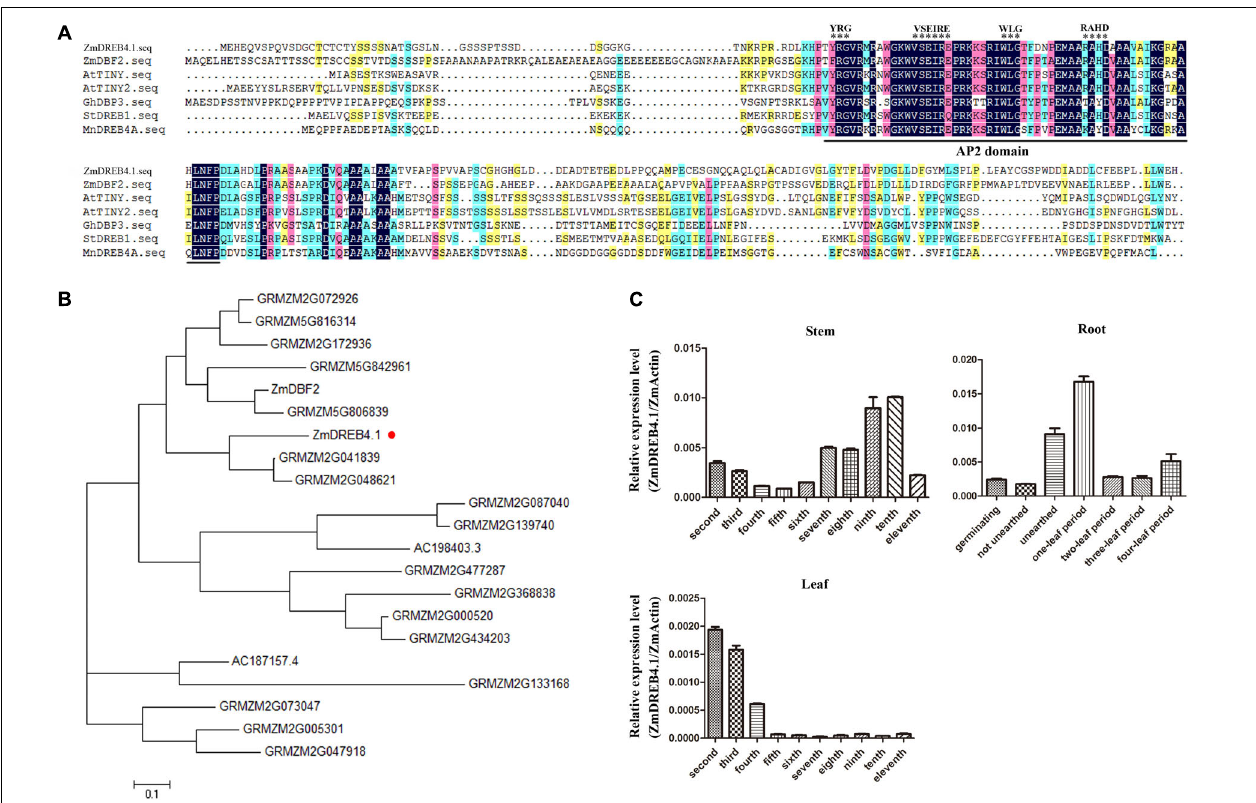
FIGURE 1 | Multiple sequence alignment and expression analysis of ZmDREB4.1 . (A) Multiple sequence alignment between ZmDREB4.1 and several reported DREB A-4 subgroup members from various species. The conserved AP2 domain is marked by a black line and the VSEIRE/Q, YRG, RAYD, and WLG motifs are marked by black asterisks. (B) Phylogenetic analysis of the DREB A-4 subgroup transcription factors from maize. The tree was generated by the neighbor-joining method using the full-length protein sequences. ZmDREB4.1 is highlighted by a round red dot. (C) The relevant expression levels of ZmDREB4.1 (the expression level of ZmDREB4.1 /the expression level of ZmActin ) analyzed by qRT-PCR in maize roots, stems and